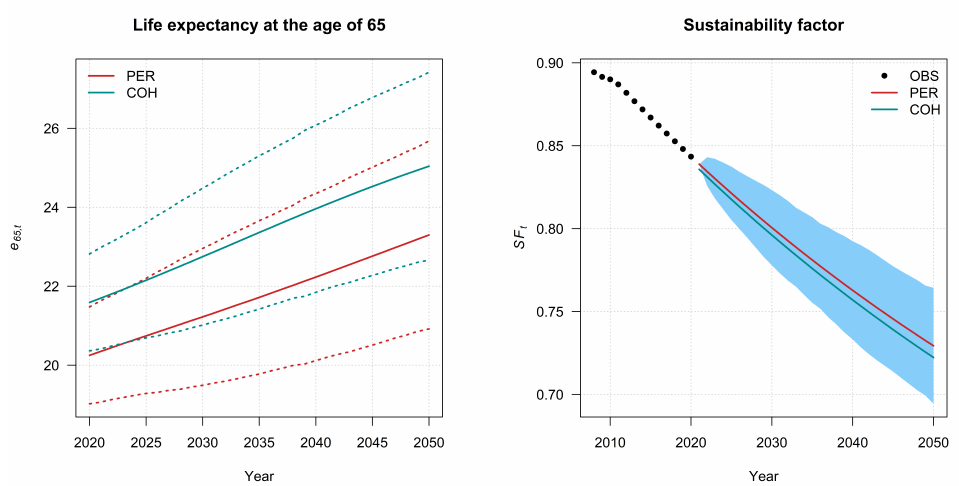
Figure 4. Portugal: forecasts of the life expectancy and sustainability factor. The solid lines in the left panel represent the period (PER) or cohort (COH) life expectancy estimates at the age of 65, with the dashed lines representing the corresponding 95% MATA prediction intervals. In the right panel, the dots correspond to the observed values of the sustainability